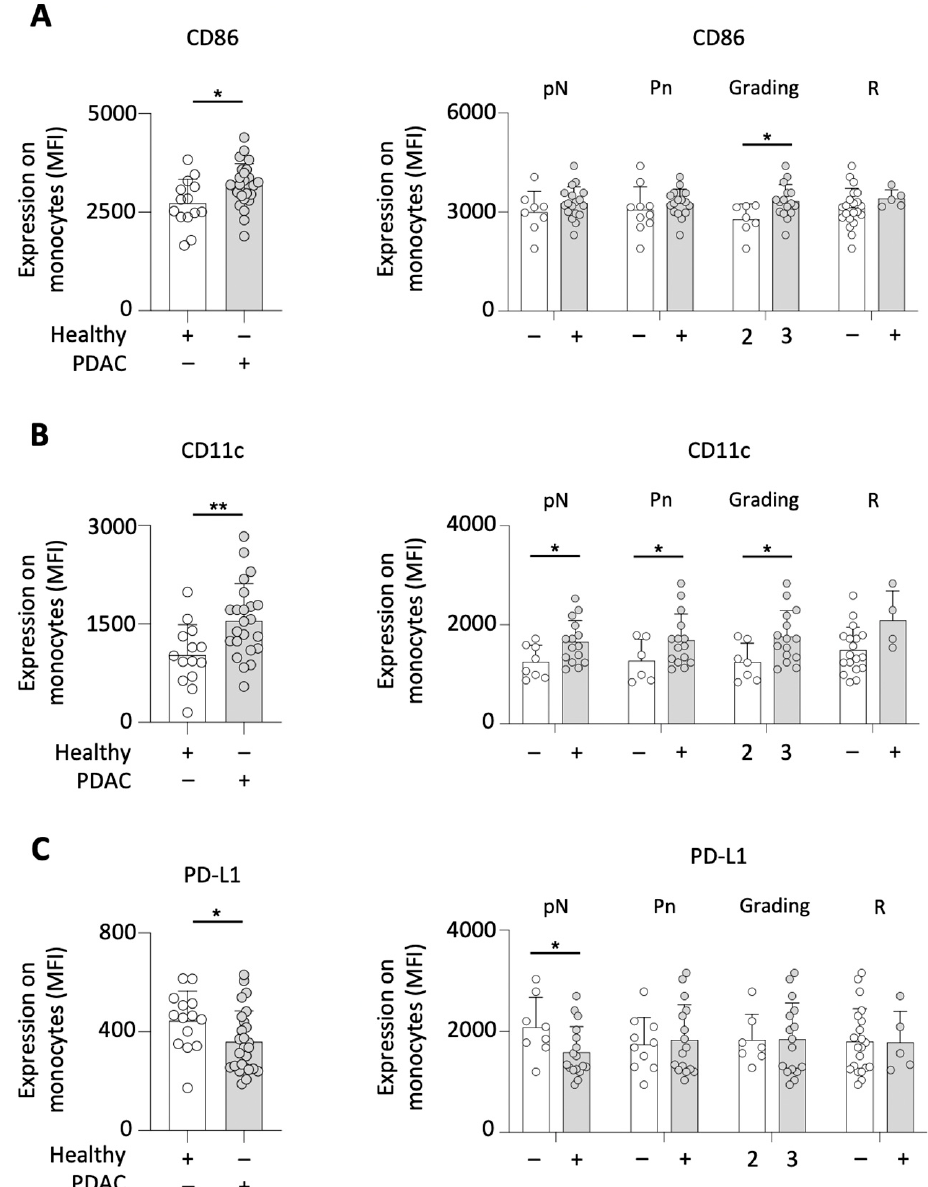
Figure 2. PDAC patients demonstrated an increased activation status of circulating monocytes. Analysis of PDAC patients’ monocytes compared to healthy individuals and correlation with the disease severity (lymph node status (pN), perineural invasion (Pn), the tumor grading (G) and the resection status (R)) for the expression of CD86 on ( A ); CD11c ( B ); and PD-L1 ( C ); * p < 0.05; ** p < 0.01. CD11c was also expressed more abundantly on monocytes of PDAC patients com- pared to healthy individuals. Clinically, CD11c expression was shown to correlate with the invasion of lymph nodes. While the expression of CD11c was increased in patients with G3 and Pn + tumors, the analysis of the resection status revealed no CD11c-related differences (Figure